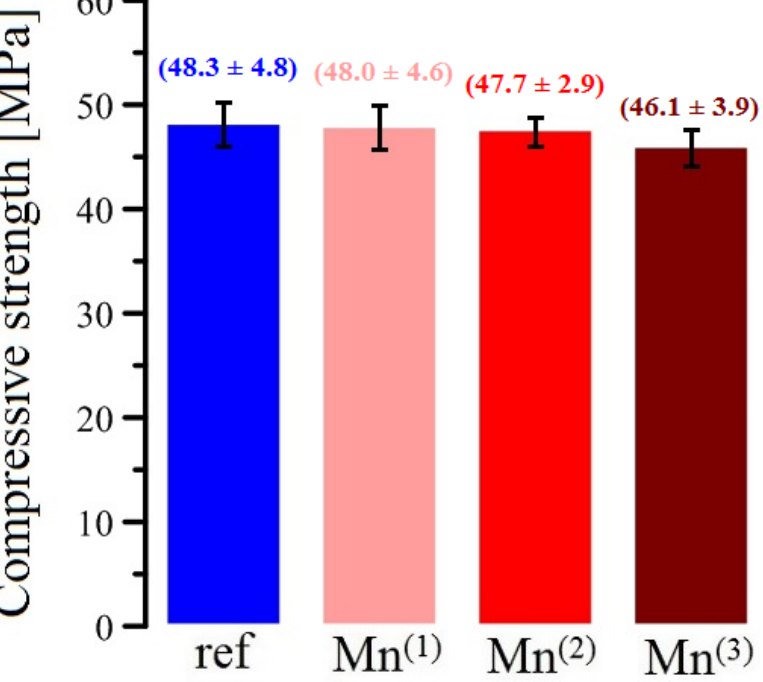
Figure 14. Comparison of compressive cubic strength of NSC samples with different levels of MnO 4 − addition. MnO − 4